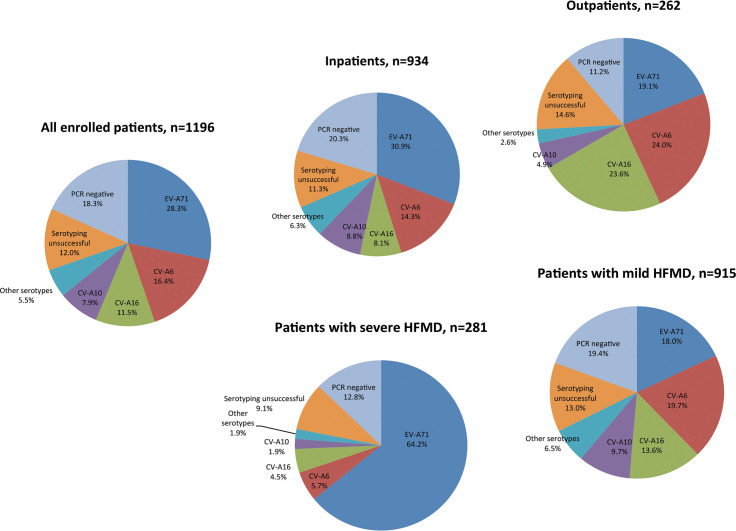
Pie charts showing the detection rates of enterovirus serotypes in all HFMD patients enrolled in the study and groups of patients with severe and mild HFMD, and in- and outpatients.